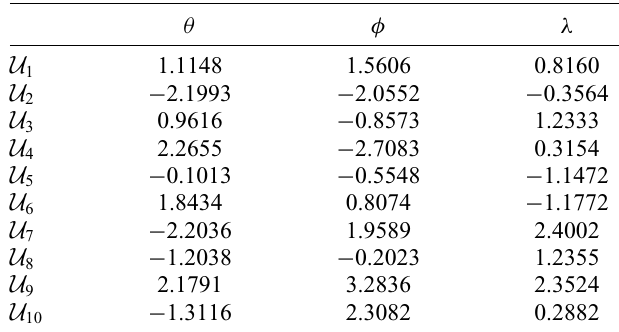
TABLE II. A set of 30 parameter values that constitute a set of ten unitary gates with minimal average mutual